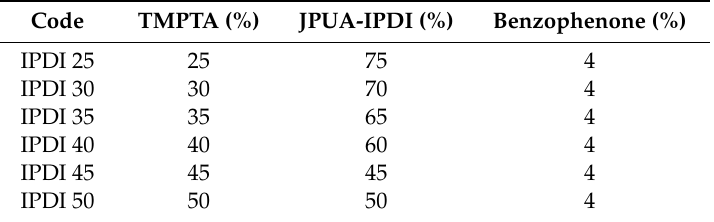
Table 2. Components of jatropha oil-based polyurethane-isophorone diisocyanate (JPUA-IPDI)- based coating. Code TMPTA